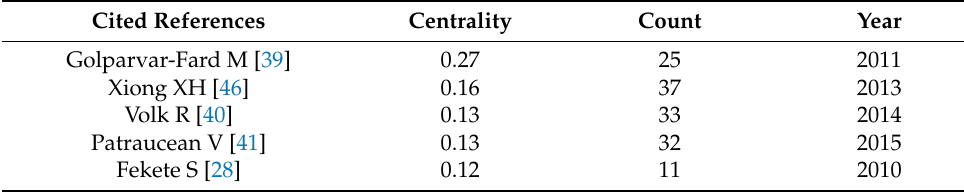
Table 4. List of Top 5 high-centrality papers and related network